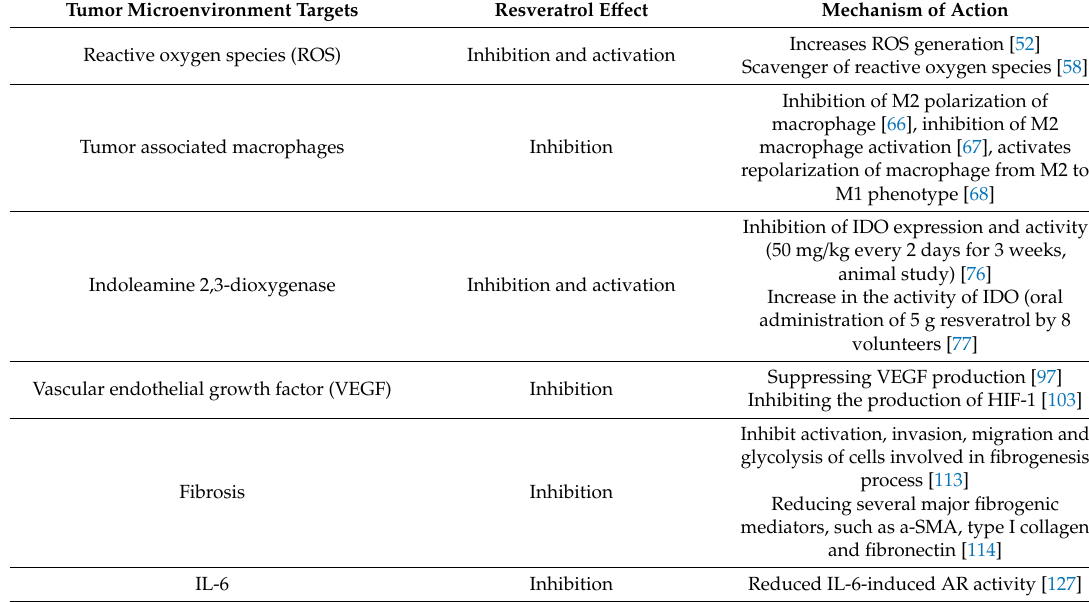
Table 2. E ff ect of resveratrol on di ff erent targets in tumor